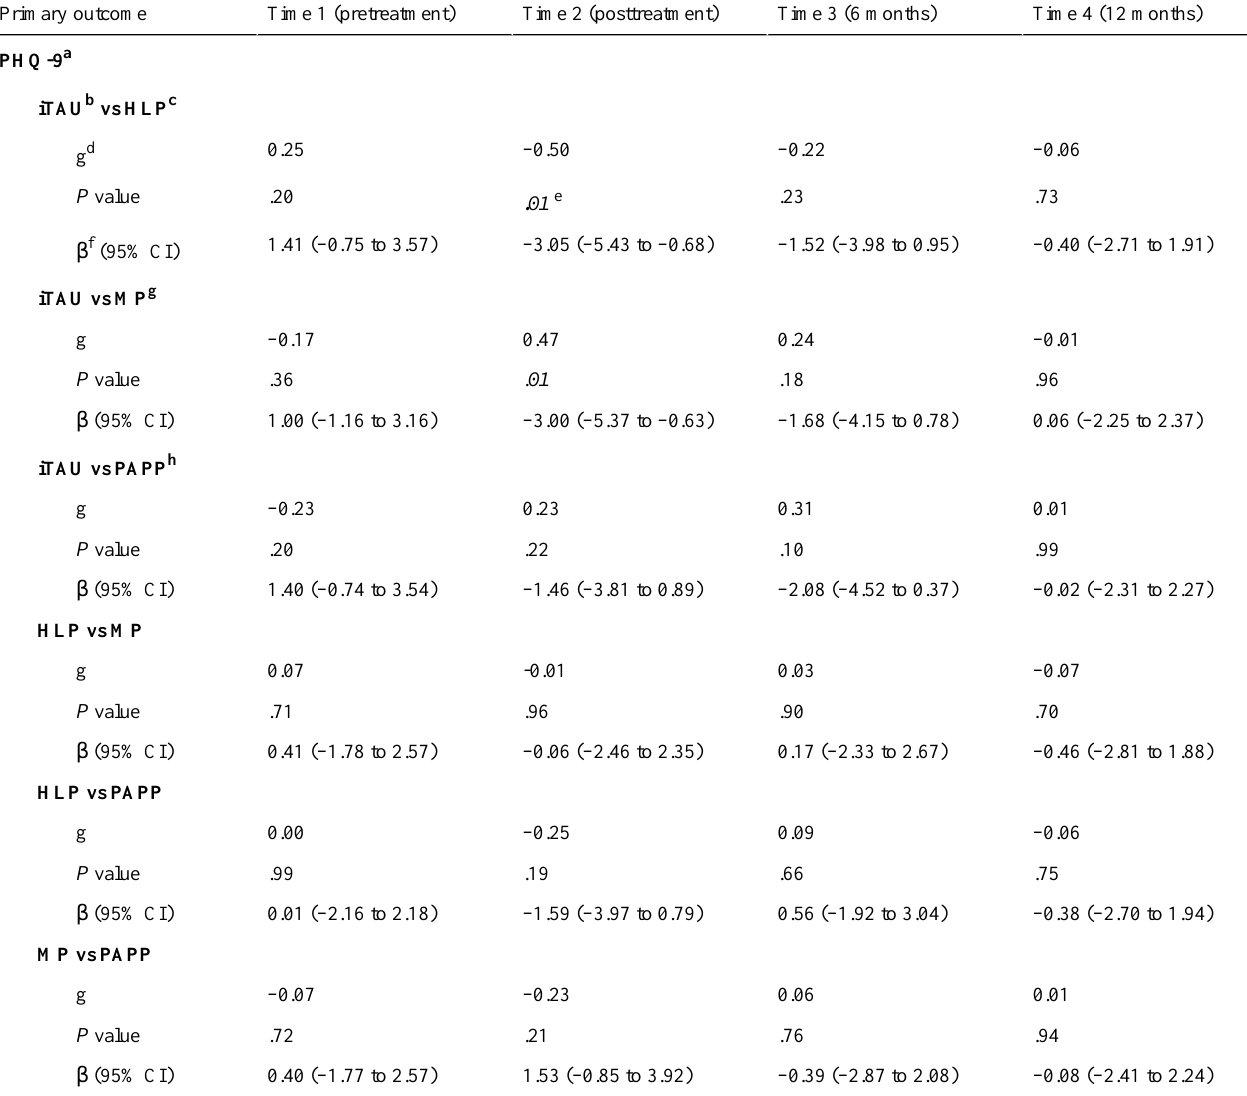
Table 3. Primary outcome analysis with imputed data (N=221): intervention comparisons along the